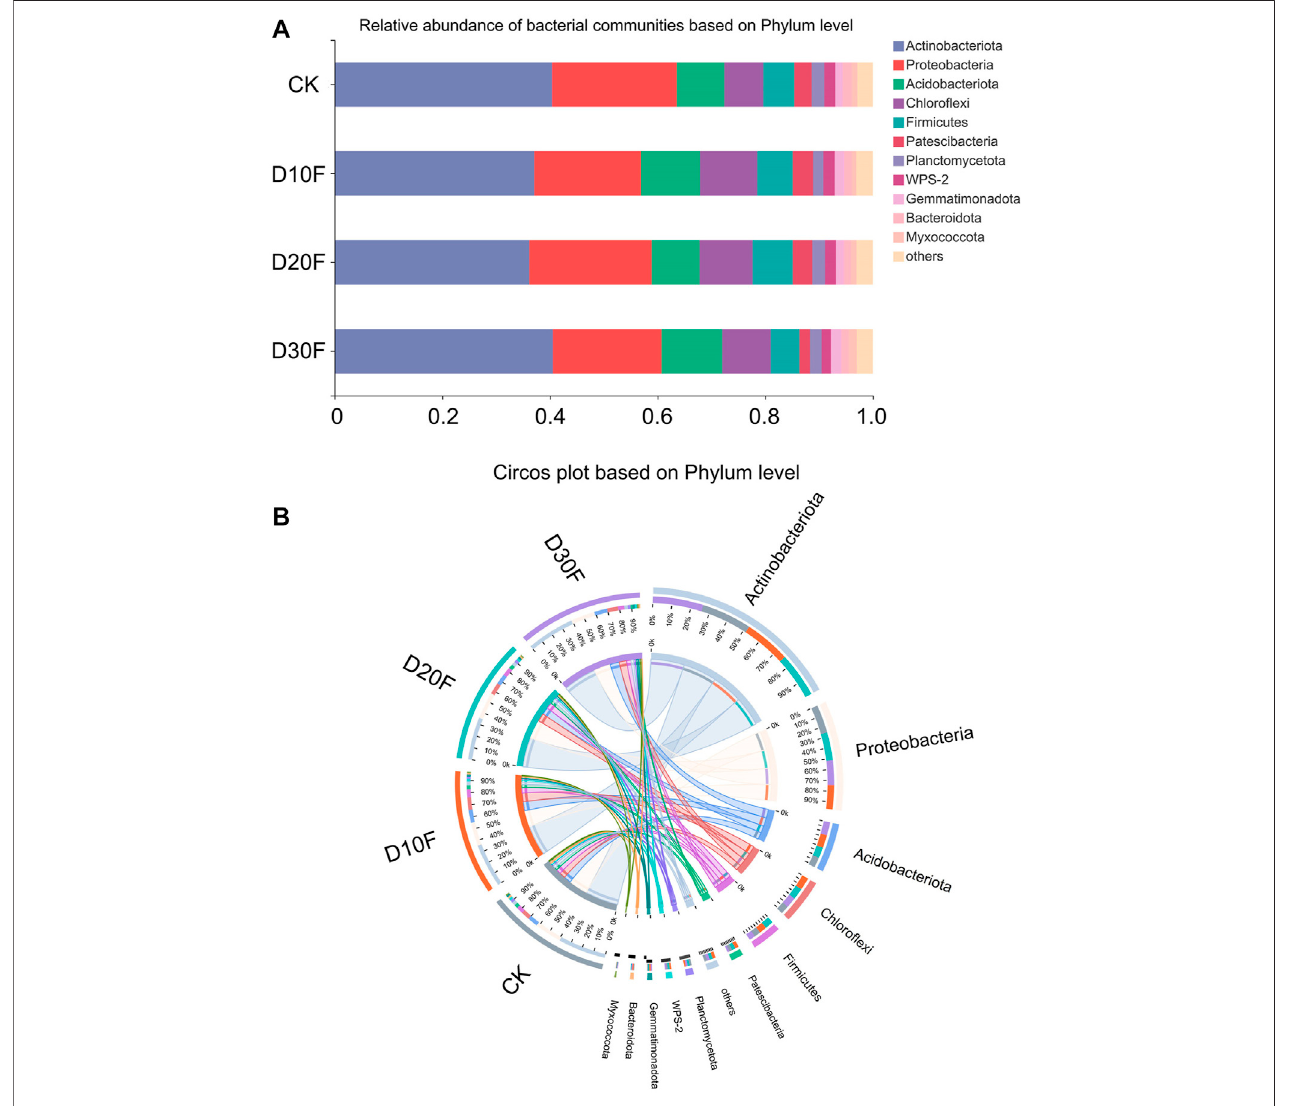
FIGURE2| Compositionofthebacterialcommunitiesfordifferenttreatments,basedonphylum. (A) Barplotofrelativeabundanceofbacterialcommunitiesbased on phylum. (B) Circos plot of different treatments based on phylum.